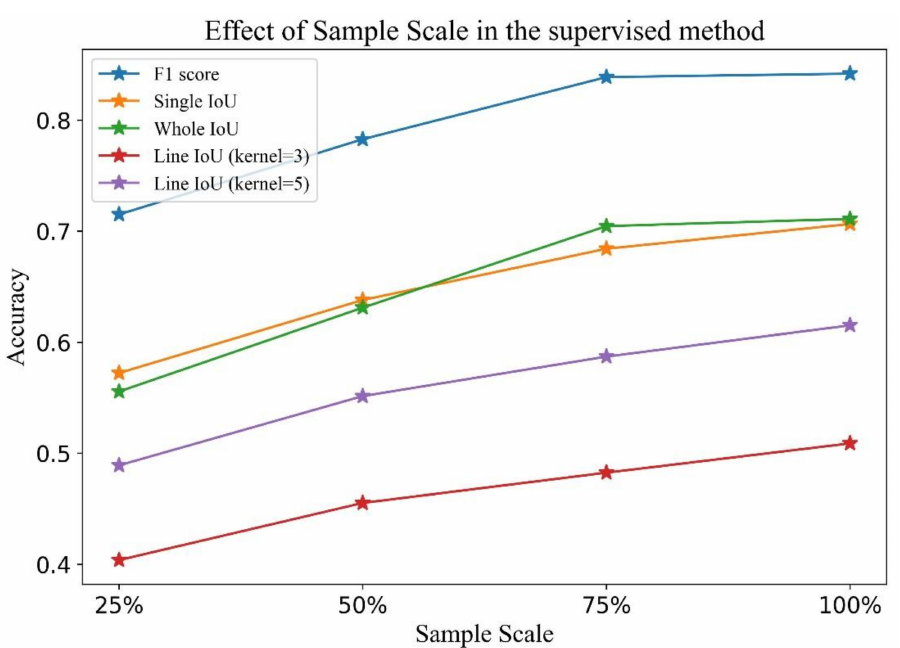
Figure 5. Precision evaluation results for the effect of the sample scale in the supervised method. This figure contains all the results obtained by our proposed network with the fully supervised